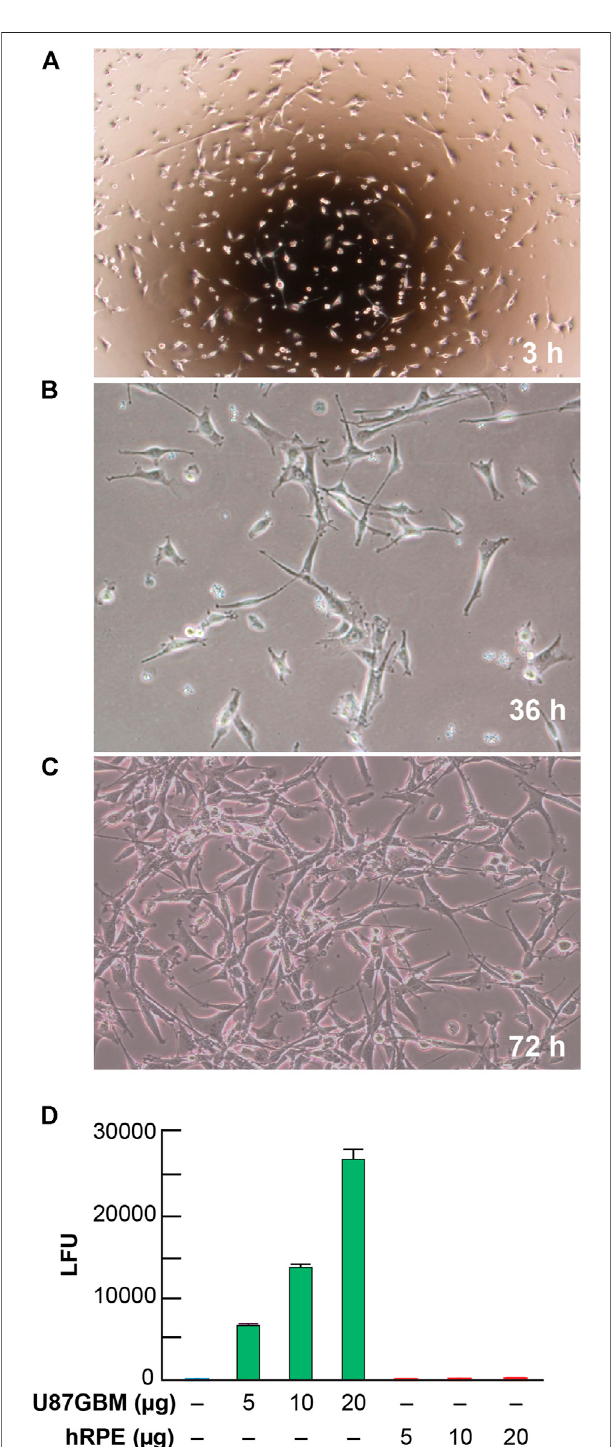
FIGURE2| MorphologicalgrowthandluciferaseactivityinU87MG cells. Representative images of U87MG cells at 3 (A) , 36 (B) , and 72 (C) hours at 20x magni fi cation after taking out of Cryofrizide. A luciferase receptor gene was used to tag the U87MG cells. Steady growth and attenuation of the morphologicalpatternofU87MGcellspresentat36and72 h. (D) Detectionof luciferase activity expressed in luciferase units (LFU) in U87MG and hRPE cells. Results are the average of three independent